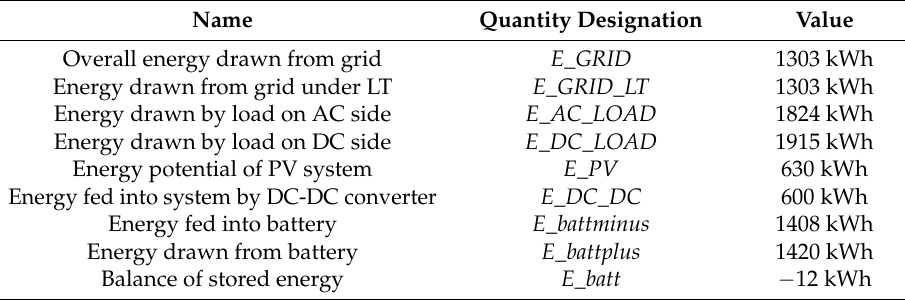
Table 6. Resulting energy balances for scenario